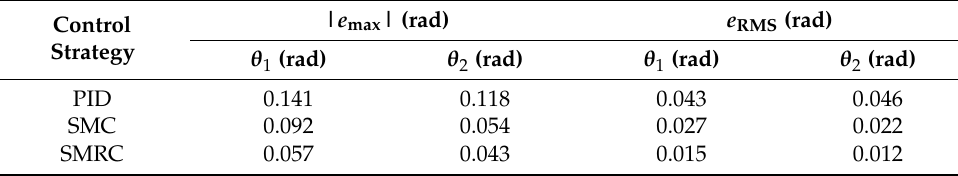
Table 7. Tracking error